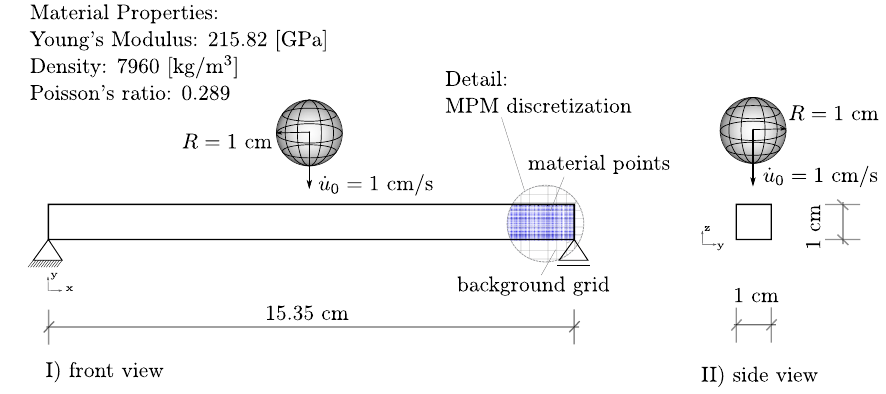
Fig. 6 Single spanned beam hit at its center by a sphere